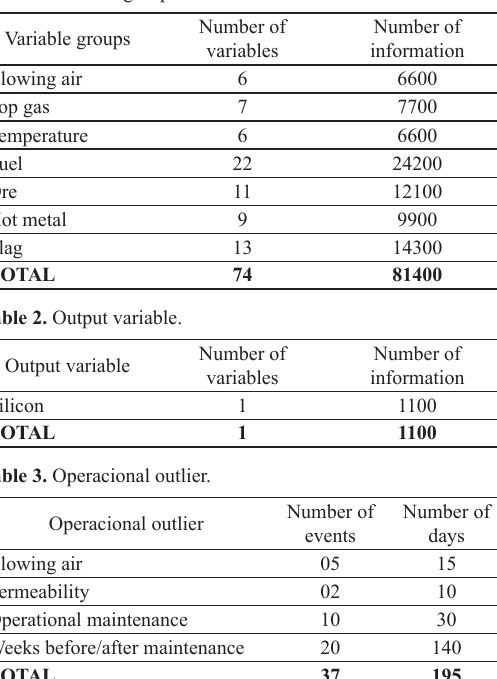
Table 1. Variable group division.